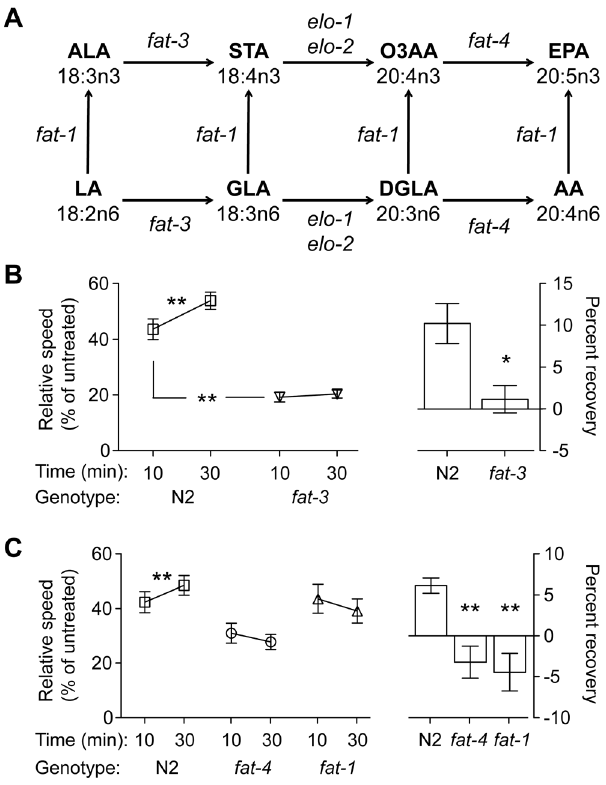
Figure 1. Long-chain polyunsaturated fatty acids are required for the development of acute functional tolerance to ethanol. (A) The metabolic pathway for LC-PUFAs in C. elegans . Genes encoding enzymes responsible for each step of the generation of each LC-PUFA are shown over the arrows. Mutations in genes encoding the enzymes FAT - 3, FAT - 4 and FAT - 1 eliminate downstream LC-PUFAs [23,26–28]. (B– C) N2 animals develop acute functional tolerance (AFT) to ethanol, whereas fat-3(wa22), fat-4(wa14), and fat-1(wa9) fail to develop AFT. Animals were treated with 0 or 400 mM ethanol, and locomotion was recorded at 10 and 30 minutes of exposure. Here and in subsequent figures, left graphs show relative speeds (treated/untreated speed). A difference at 10 minutes between N2 and the mutant indicates that the mutant has a change in initial sensitivity; a significant increase in speed from 10 to 30 minutes within a strain is defined as the development of AFT. Right graphs show percent of speed recovered between 10 and 30 minutes within a strain; this is the degree of AFT. fat-3(wa22) is more sensitive than wild type to the intoxicating effects of ethanol at 10 minutes in this set of experiments, although in subsequent experiments, this difference did not reach statistical significance. Error bars represent SEM. * p , 0.05; ** p , 0.01. n